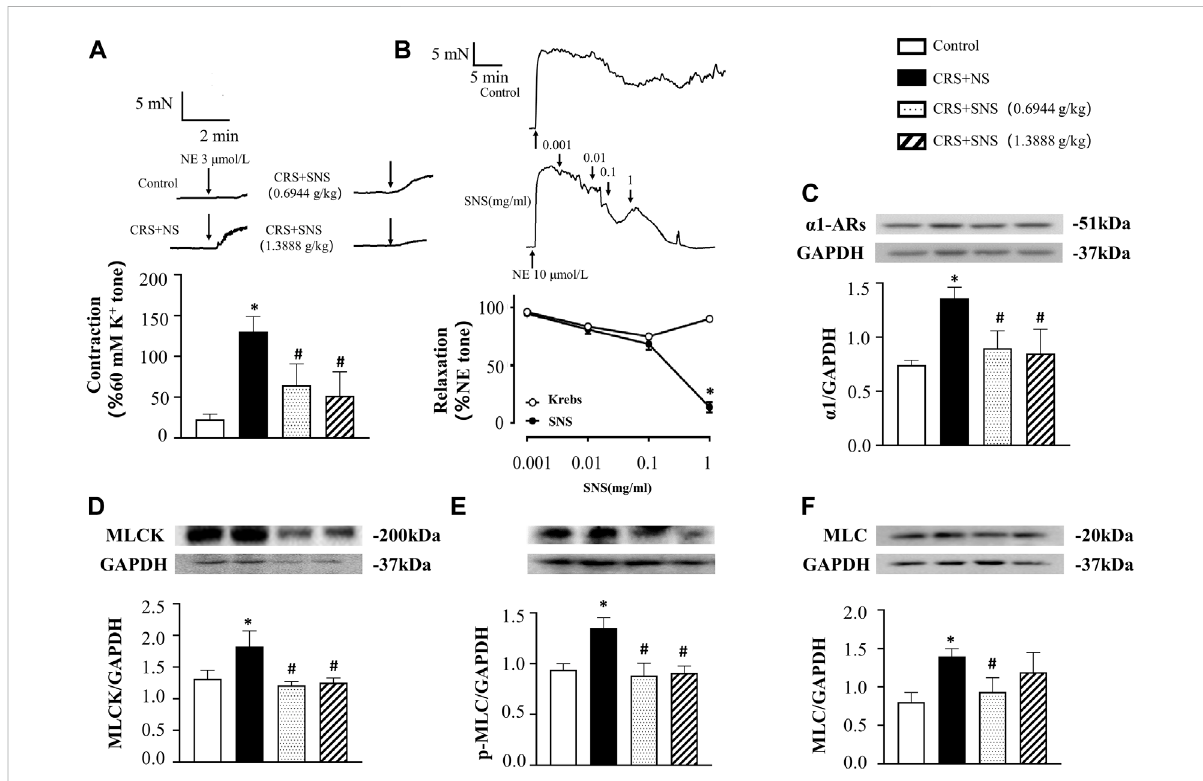
FIGURE 5 Effect of the SNS treatment on the contraction and expression of α 1-ARs, MLCK, p-MLC, and MLC in mesenteric arteries. (A) 3 μ mol/L NE- induced contraction in the rat mesenteric arteries. F = 23.36. p < 0.0001. (B) SNS-induced relaxation in mesenteric arteries. (C) Western blot of α 1- ARsinmesentericarteriesfromdifferentgroupswiththequanti fi cation shownbelow. F=12.49. p =0.0005. (D) WesternblotofMLCKinmesenteric arteries from different groups with the quanti fi cation shown below. F = 9.030. p = 0.0021. (E) Western blot of p-MLC in the mesenteric arteries from different groups with the quanti fi cation shown below. (F) = 17.28. p = 0.0001. (F) Western blot of MLC in the mesenteric arteries from different groups with quanti fi cation showing below. F = 6.582. p = 0.0070. Results are presented as mean ± SEM. * p < 0.05 vs. Control group; # p < 0.05